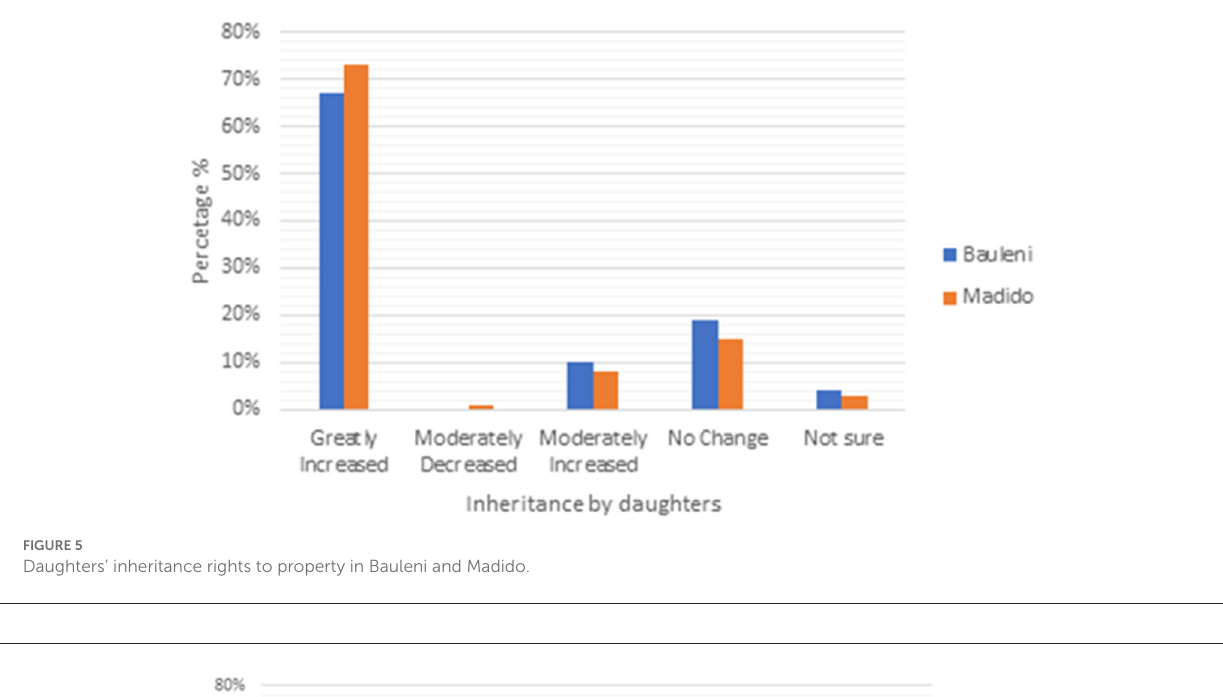
FIGURE5 Daughters’ inheritance rights to property in Bauleni and Madido.